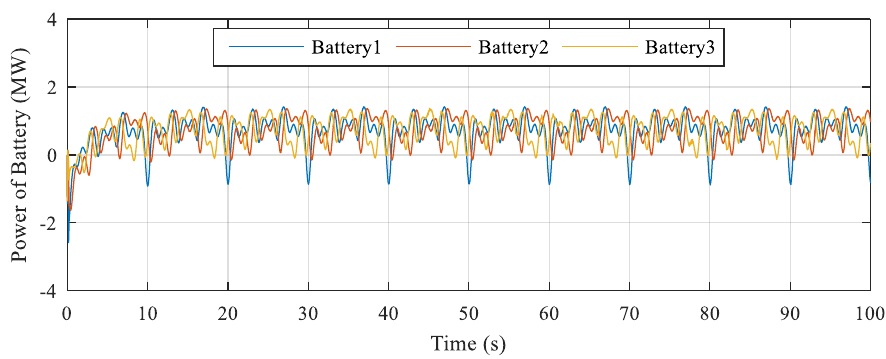
Figure 11. Power of battery without the proposed controller (Case 1).